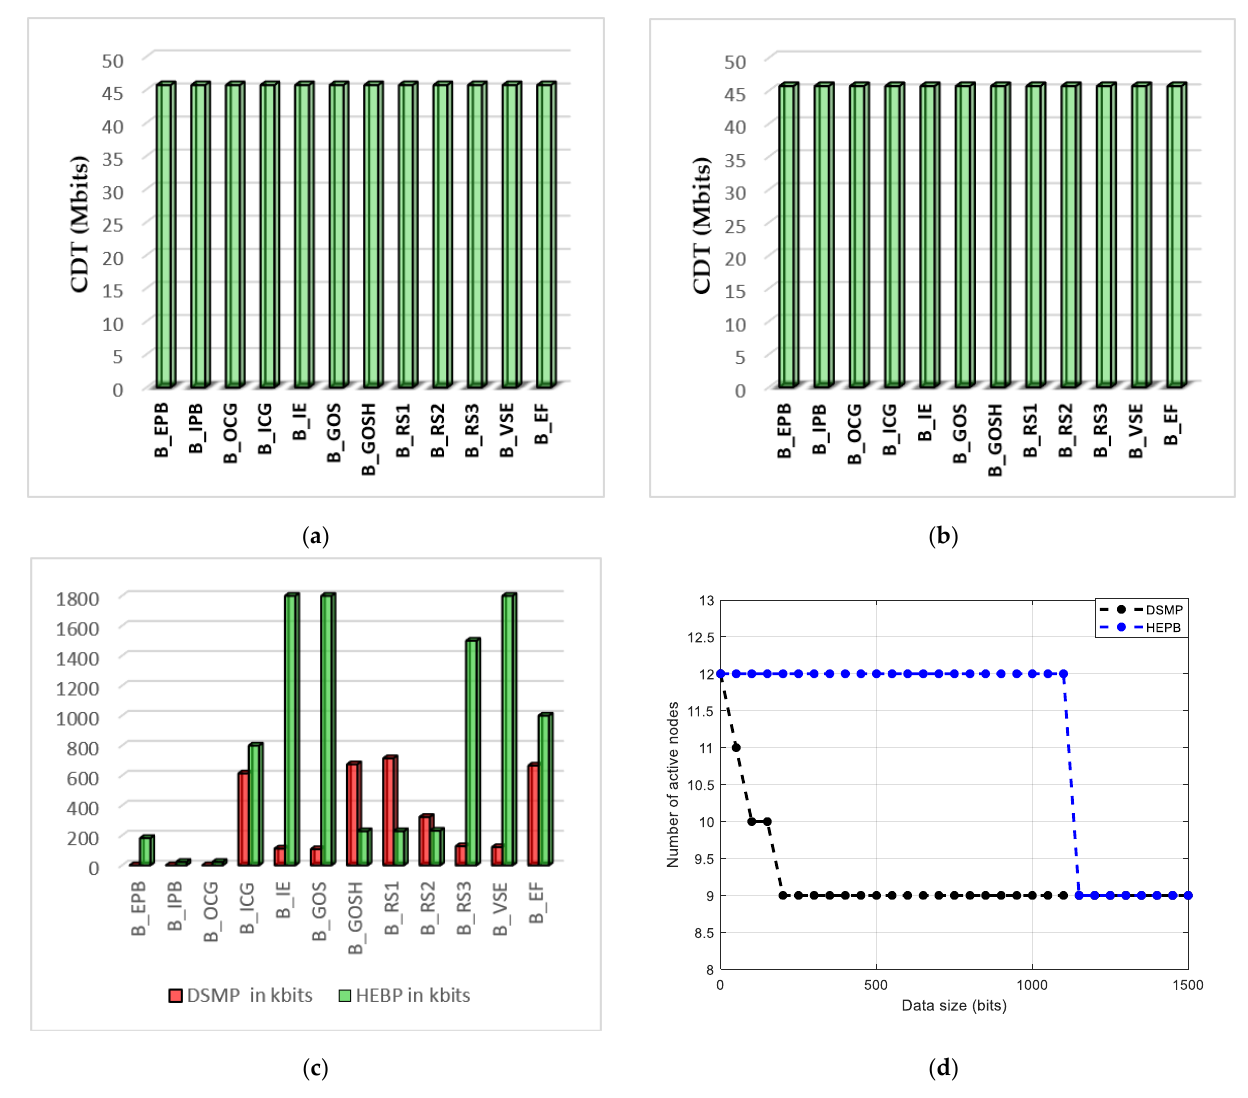
Figure 14. Comparison of HEPB performance with DSMP. ( a ) 𝑏 = 512 bits . ( b ) 𝑏 = 1024 bits . ( c ) 𝑏 ∈ [128 bits, 4096 bits] . ( d ) HEBP efficiency range.